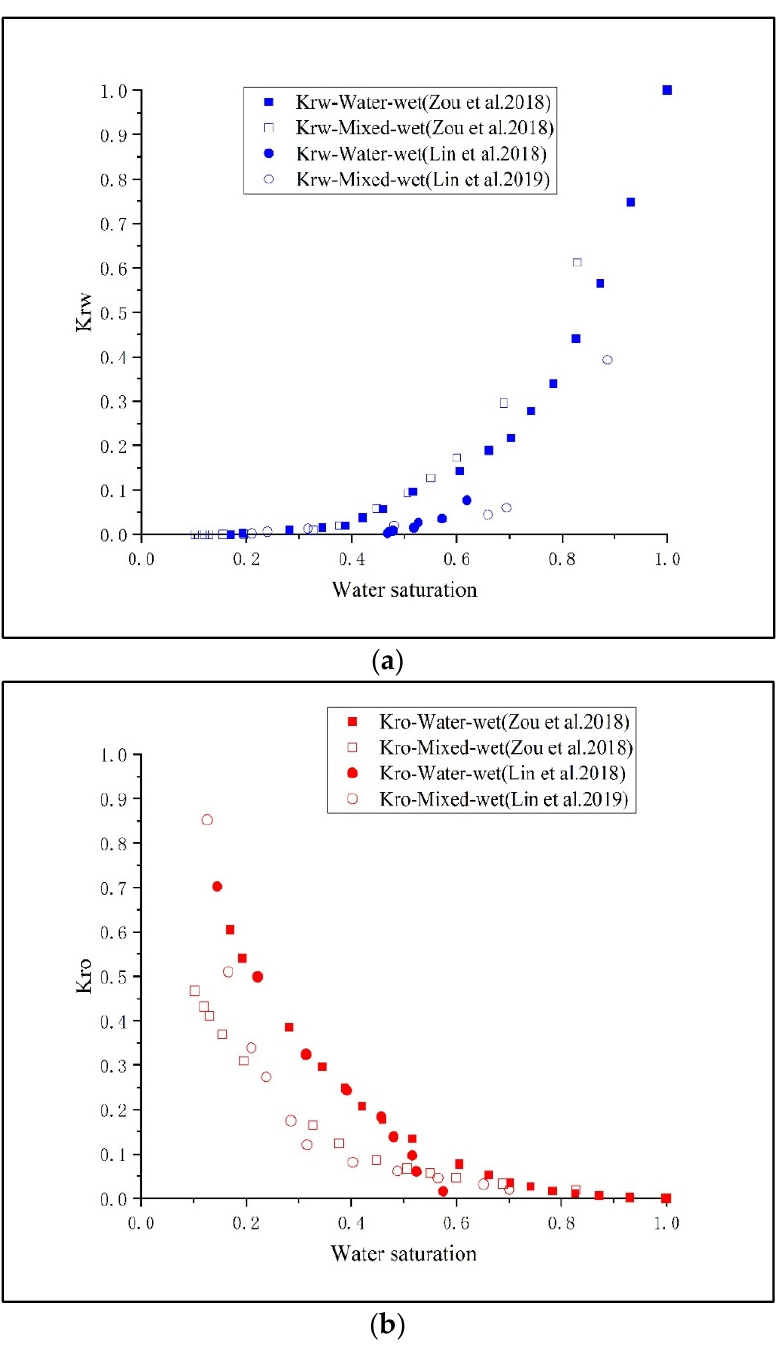
Figure 6. Comparison of relative permeability results measured by the laboratory for water phase ( a ) and oil phase ( b ) in water-wet and mixed-wet cases for Zou’s [15] and Lin’s work [41,42].